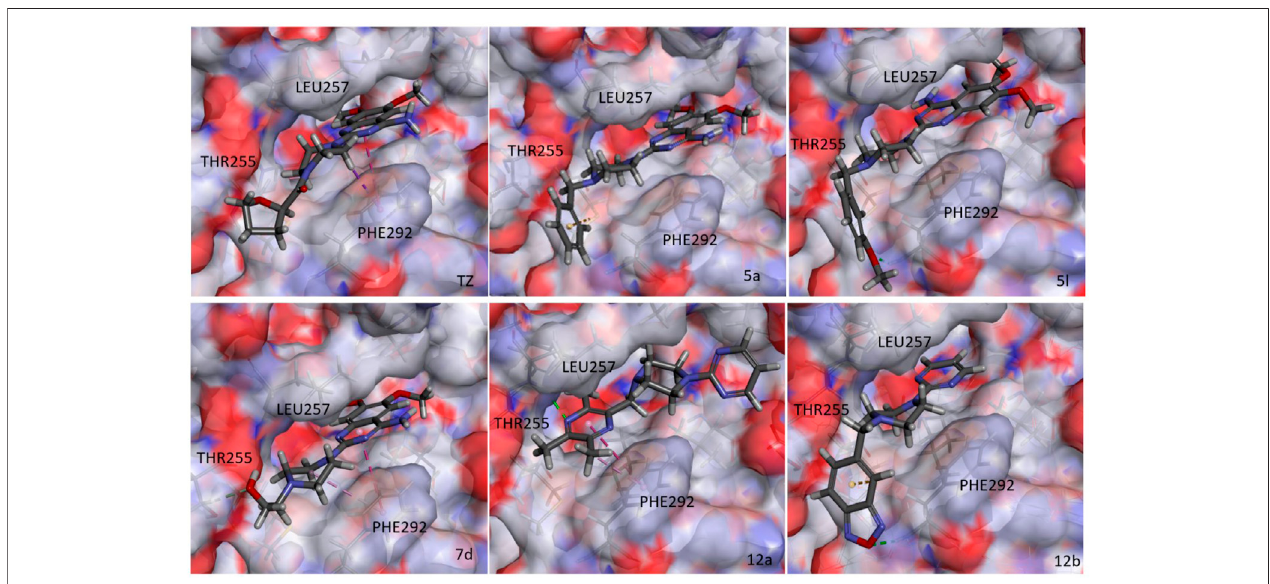
FIGURE 3 | Docking study of terazosin analogs and Pgk1 (PDB ID: 4O3F).